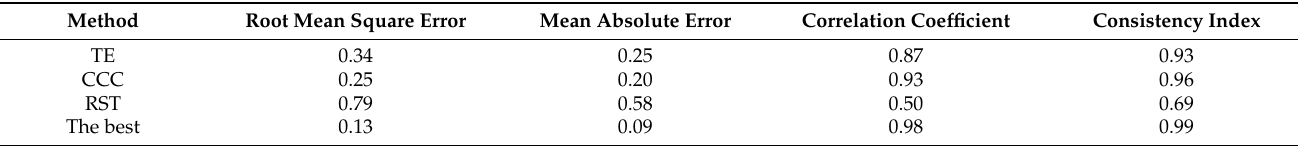
Table 4. The estimation precision index values of the whole growth process. Method Root Mean Square